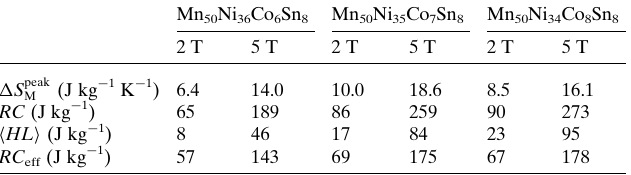
Table 2 Maximum magnetic entropy change ( (cid:2) S peak average hysteresis loss ( h HL i ) and effective refrigerant capacity ( RC eff ) values for Mn